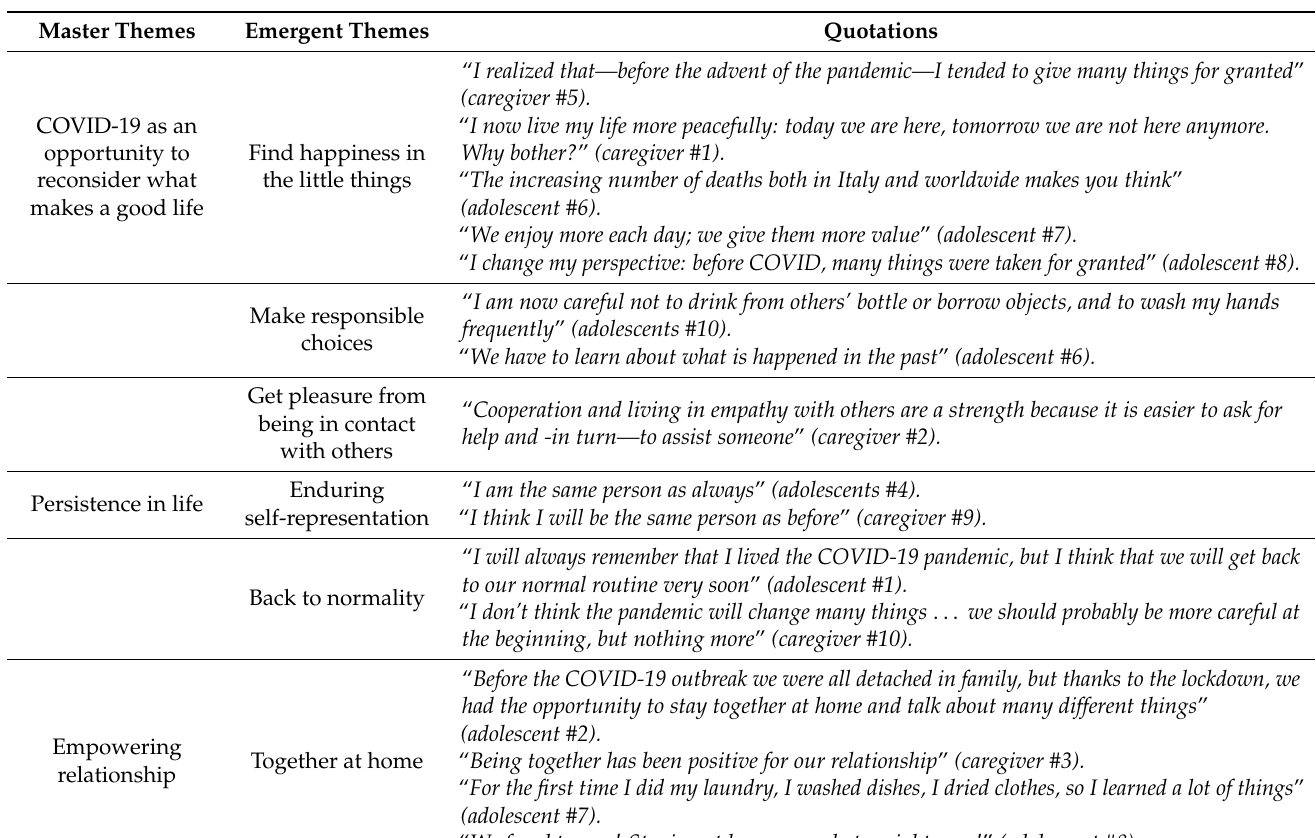
Table 2. Master themes, emergent themes, and quotations of the